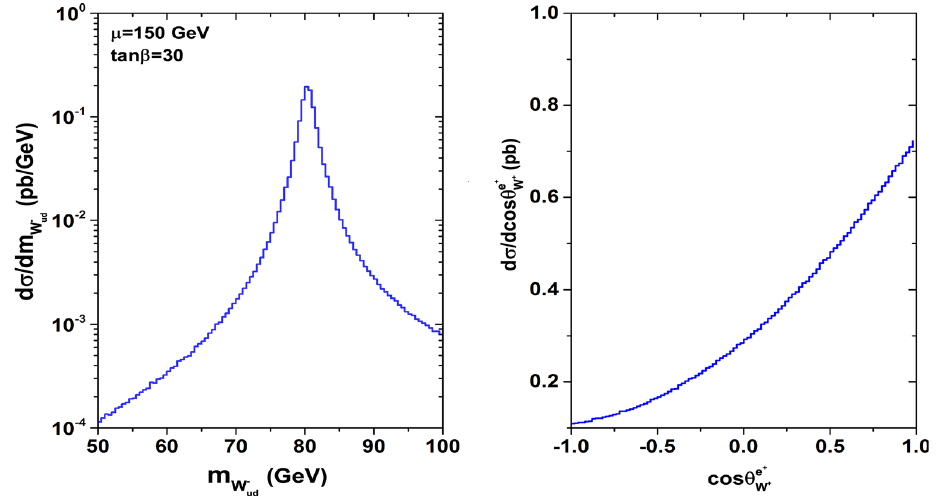
Fig. 1 Parton-level kinematic distributions of the process e + e − → W + ( → e + ν e ) W − ( → ¯ ud ) at the CEPC. m ¯ ud is the invariant mass of ¯ u and d quarks from W − decay (left panel) and cos θ e Fig. 2 Scatter plot of relative one-loop corrections to the process e + e − → W + W − in the higgsino world of MSSM at the CEPC. The blue vertical dash-dot lines are the expected 5 σ sensitivity of LHC search for the higgsino world via mono-jet plus soft dileptons plus / E T [35]